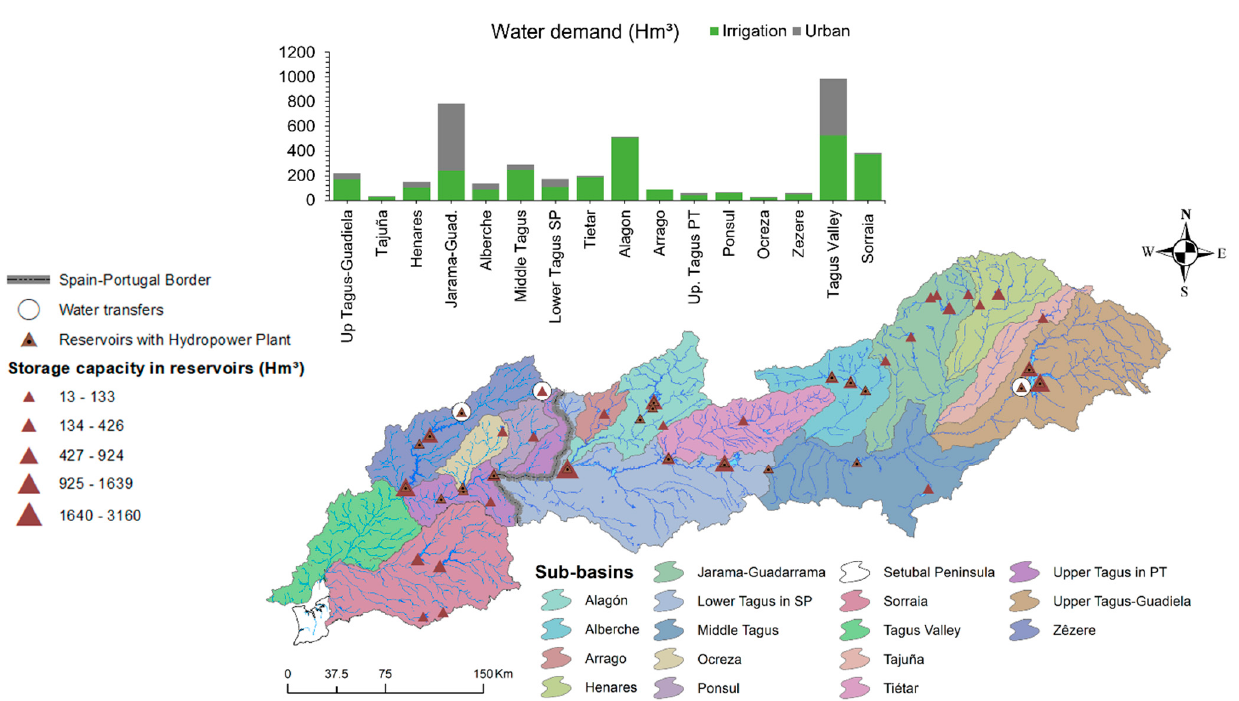
Figure 1. Tagus River basin and its human-induced pressures (hydraulic infrastructure and water demand) within sub-basins.